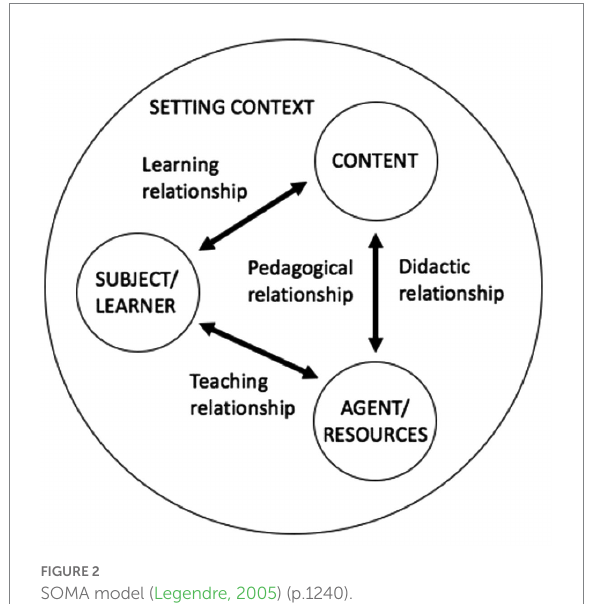
FIGURE 2 SOMA model (Legendre, 2005)